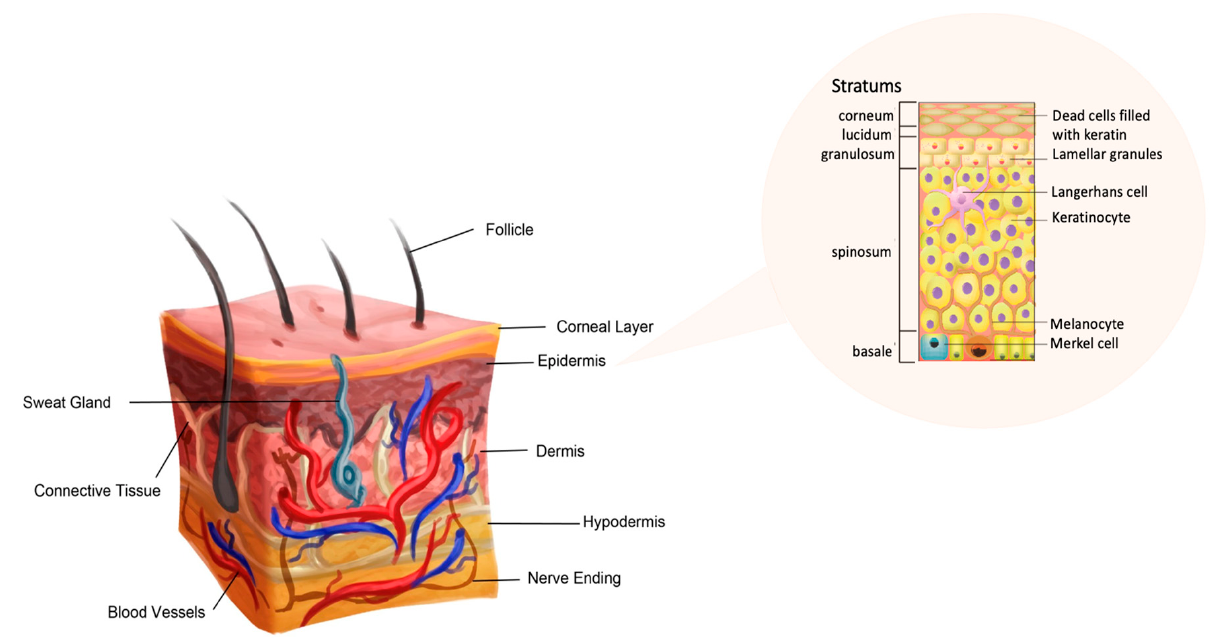
Figure 3. The structure of skin with all the characteristic of stratums. Copyright permission for the reuse from the ref. [44,45].